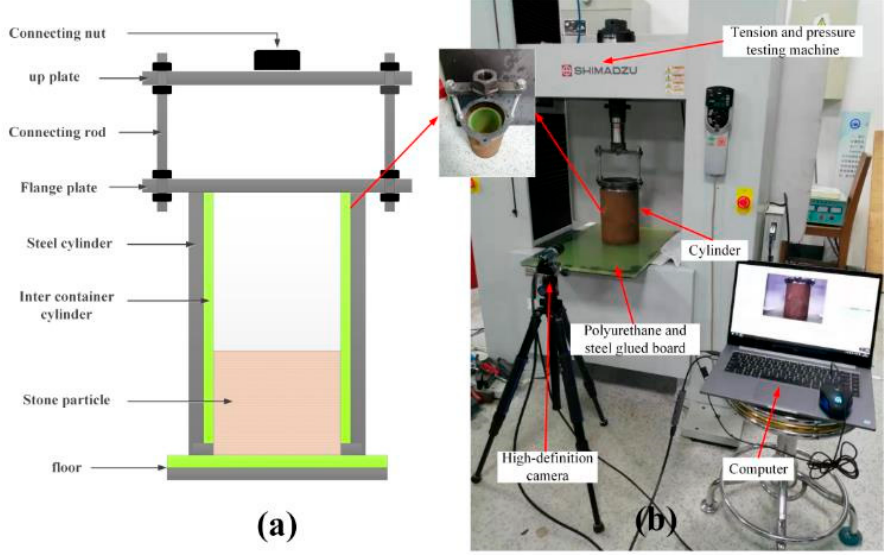
Figure 3. Experimental setup for the wet particle calibration: ( a ) schematic diagram of cylindrical device, and ( b ) experiment scene of cylinder lifting.